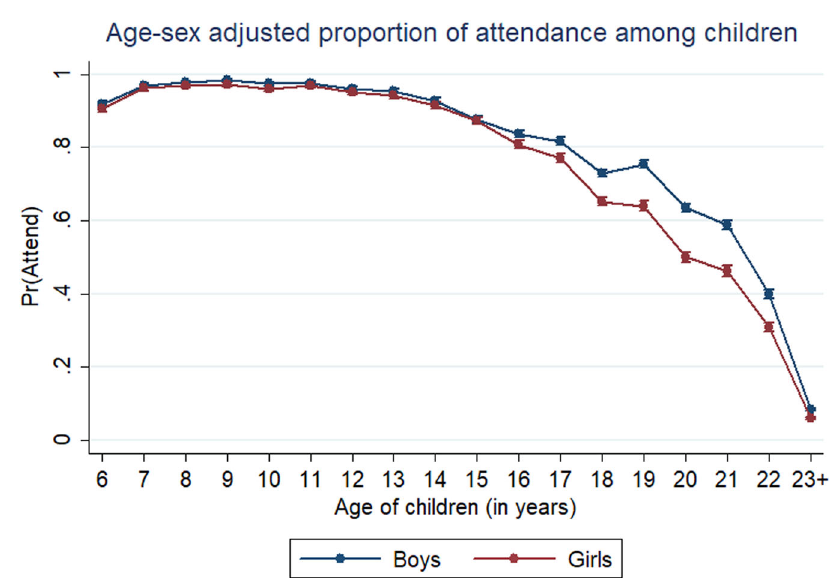
Fig. 1 Age-sex adjusted proportion of school attendance among children aged 6 – 22 and 23 – 35 years in India, (2017 –